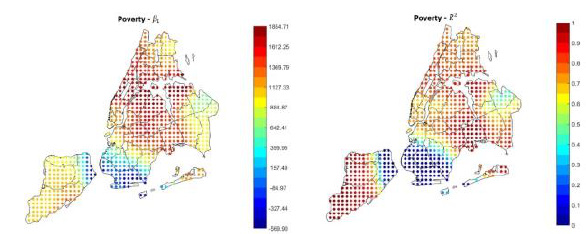
Figure 5. Result of the univariate model that correlates asthma hospitalizations to poverty rate. A different model is computed for a different geographical point of the city. A map of the β coefficients is shown on left, and a map of the corresponding scores is shown on the